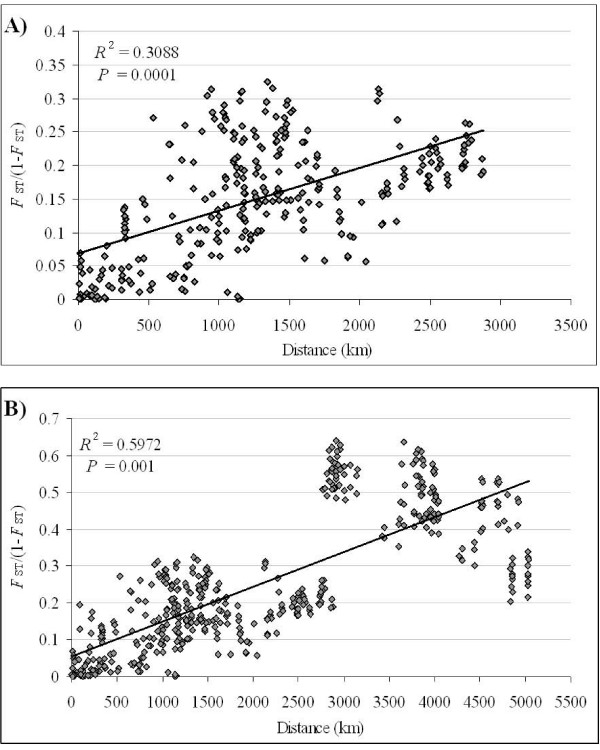
Scatterplot of pairwise FST values against geographic distance separating pairs of localities. A) shows the plot for Amazonian subpopulation comparisons; B) shows the plot for all subpopulation comparisons. The regression line is shown through the points.